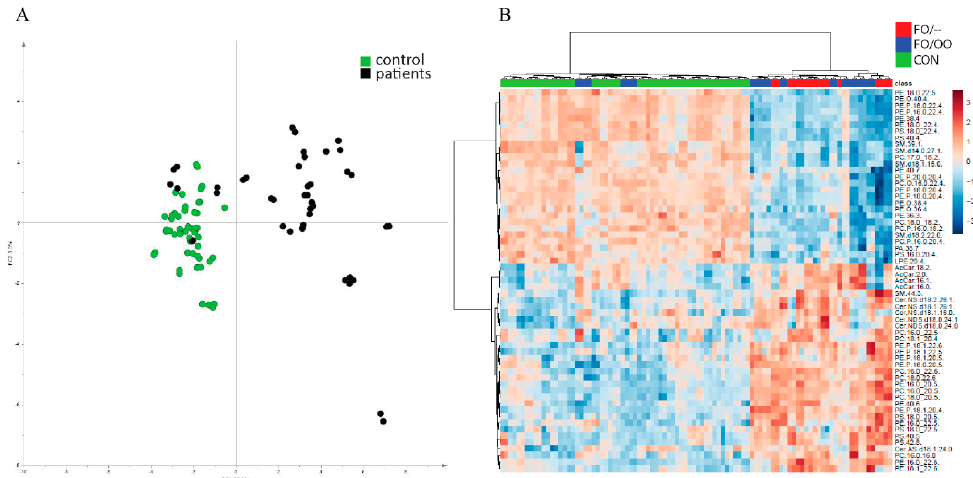
Figure 3. Erythrocyte lipidome. ( A ): Principal Component Analysis (PCA) score plot based on all confirmed erythrocyte lipids ( n = 195) showing two separated clusters of control samples as green points and patient samples as black points. The exceptions are four samples from FO/OO group,